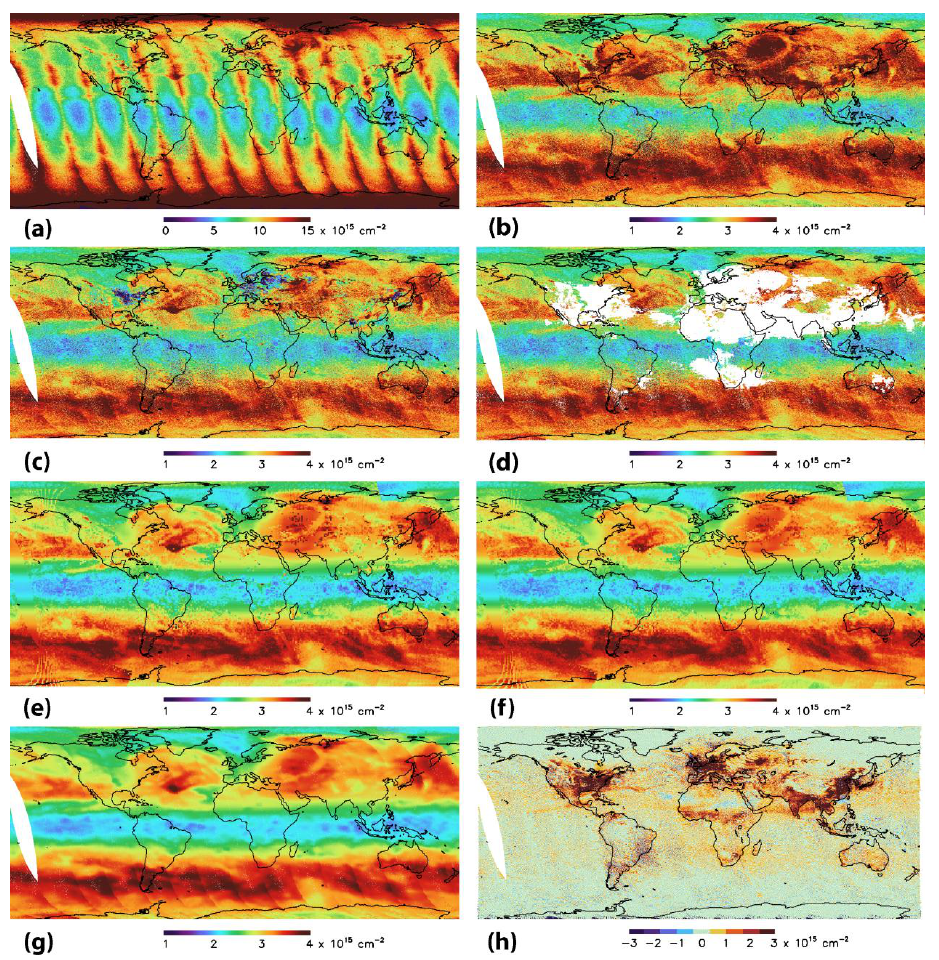
Fig. 2. Maps of 21 March 2005 OMI NO 2 data showing STS algorithm steps. (a) Slant columns. (b) V init . (c) V init minus a priori troposphere. Figure 2 : Maps of 21 March 2005 OMI NO 2 data showing STS algorithm steps. (a) Slant 2 (d) Same as (c) , but masked for pollution (white areas correspond to a masking threshold of 0.3 × 10 15 cm − 2 ). (e) Gridded, V o strat with masked columns. (b) V init . (c) V init minus a priori troposphere. (d) Same as (c), but masked for 3 areas interpolated. (f) Hot spots removed. (g) Stratosphere after final smooth, re-interpolated onto OMI pixel coordinates. (h) Tropospheric pollution (white areas correspond to a masking threshold of 0.3 ·10 15 cm –2 ). (e) Gridded, 4